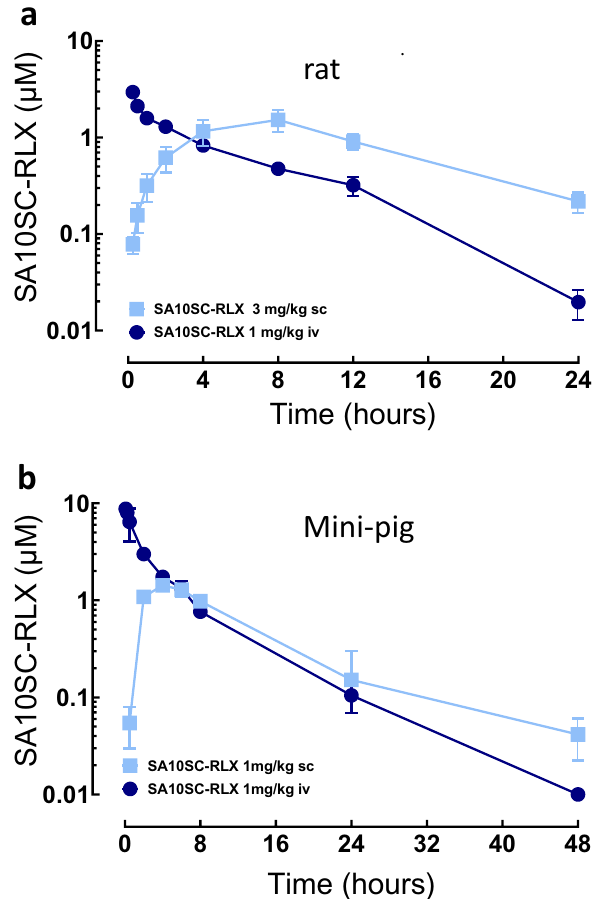
Figure 4. Pharmacokinetic properties of SA10SC-RLX after iv or sc administration in rats ( a ) or in minipigs ( b ) Blood samples were taken at each time points and SA10-SC-RLX was measured and quantified by LC-HRMS (rats) (mean ± sd, n = 3 animals per group) or LC-MS/MS (minipigs) (n = 2, individual data). Pharmacokinetics parameters were calculated by non-compartmental